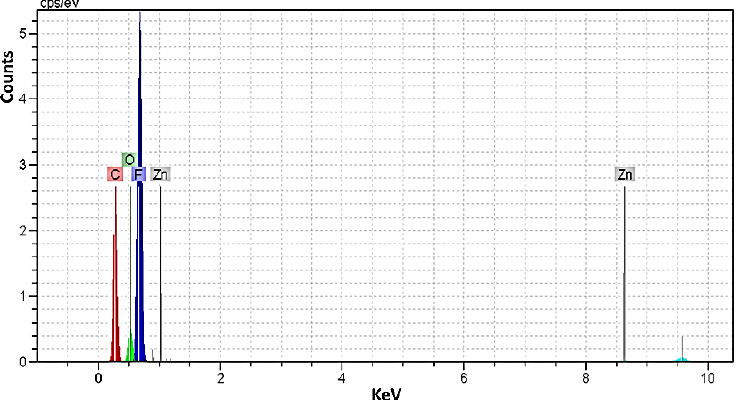
Figure 7. The EDX curve of sample 5 (PVDF) as the main composition.